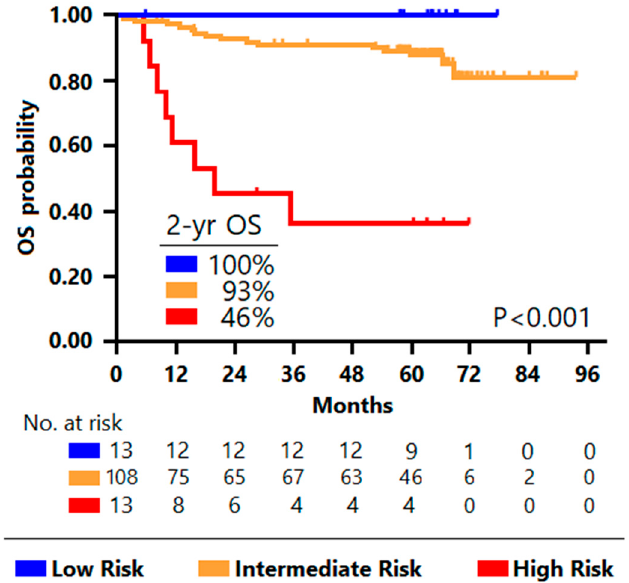
Figure 5. Kaplan–Meier overall survival estimates according to the integrative PET model derived from the classification tree. The blue curve shows the survival of low-risk patients, the yellow curve, of intermediate-risk patients, and the red one, of high-risk patients. Notably, all the high-risk patients had a non-favorable mutational profile.